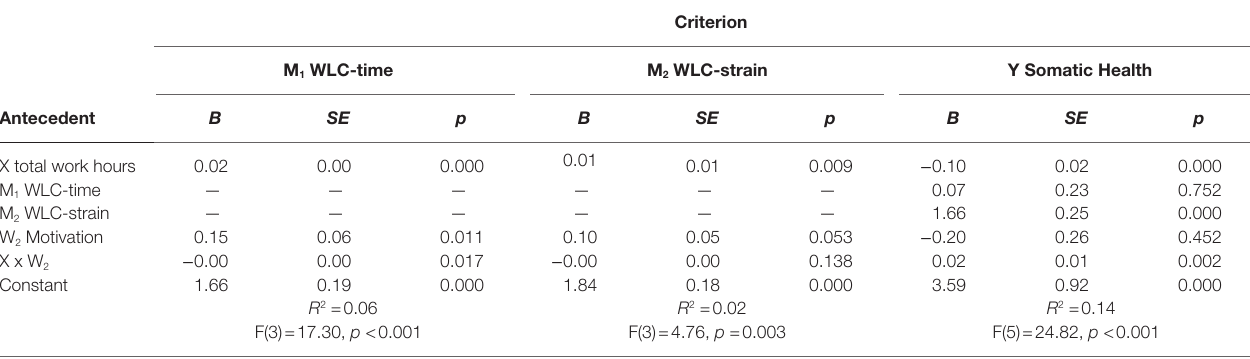
TABLE 6 | Moderated mediation analyses for the effect of total work hours on somatic health, mediated by work-life conflict, and moderated by motivation to earn money through CW .